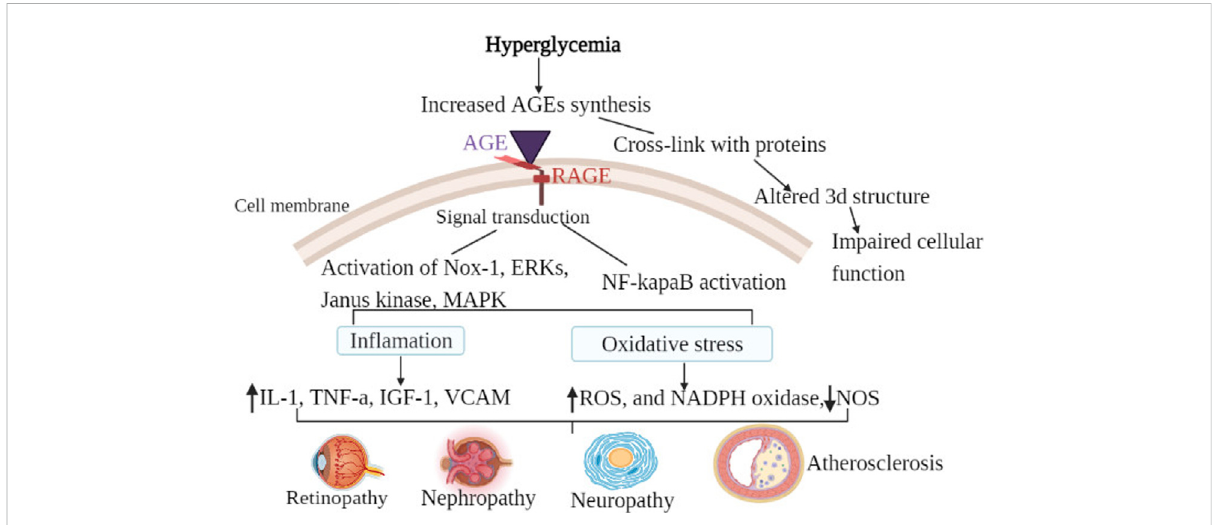
FIGURE 2 General mechanism of AGEs in diabetic chronic complications. Hyperglycemia is the most common cause of the synthesis of endogenous advanced glycation products in diabetic patients. The general mechanism of advanced glycation end-products in diabetic vascular complications is due to the activation of multiple signal transduction pathways as a result of RAGE/AGE interaction or through cross-link formation with cellular proteins. Activation of RAGE leads to the activation of Nox-1, ERKs, Janus kinase, MAPK, and activation of NF- κ B. When those pathways are activated, oxidative stress (decreased NOS, increased ROS, and increased NADPH oxidase) and in fl ammatory factors are activated. Cross-link (adduct) formation on the other hand altered the three-dimensional structure of protein consequently impairing cellular function. As a result of